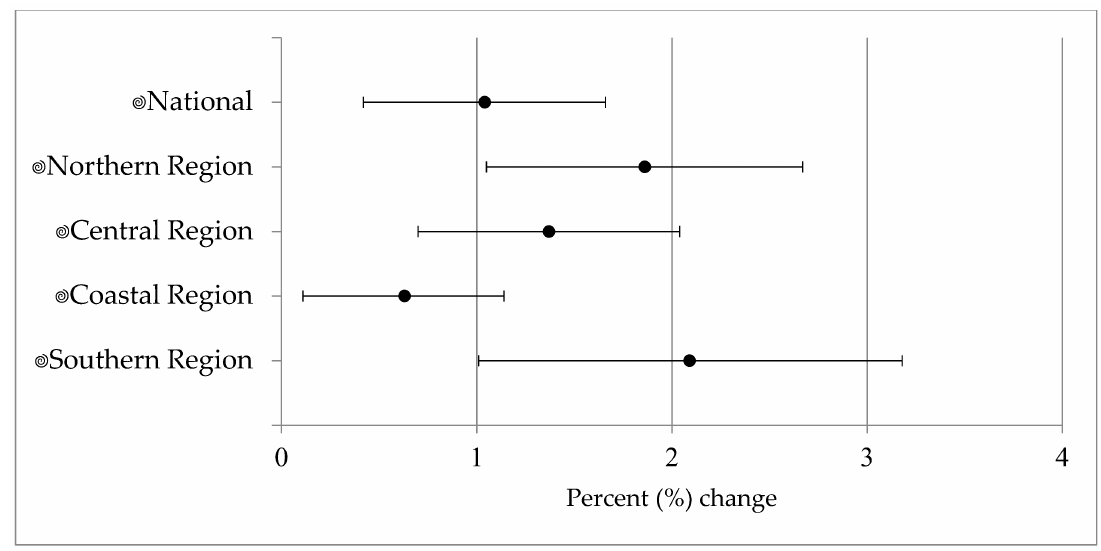
Figure 2. National and regional percent increase and 95% confidence interval in diarrheal disease associated with one additional wet day at a four-week lag, adjusted for effects at one, two, and three weeks using an unconstrained distributed lag model. The national model was adjusted for time, temperature, and region, while the regional model was adjusted for time, temperature, and district.